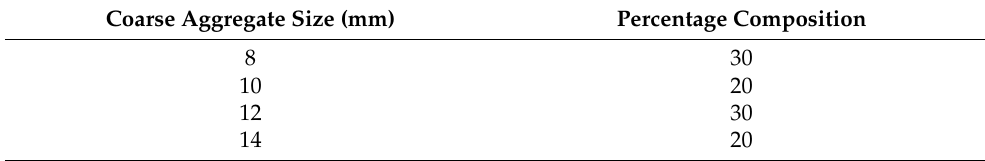
Table 2. Distribution of coarse